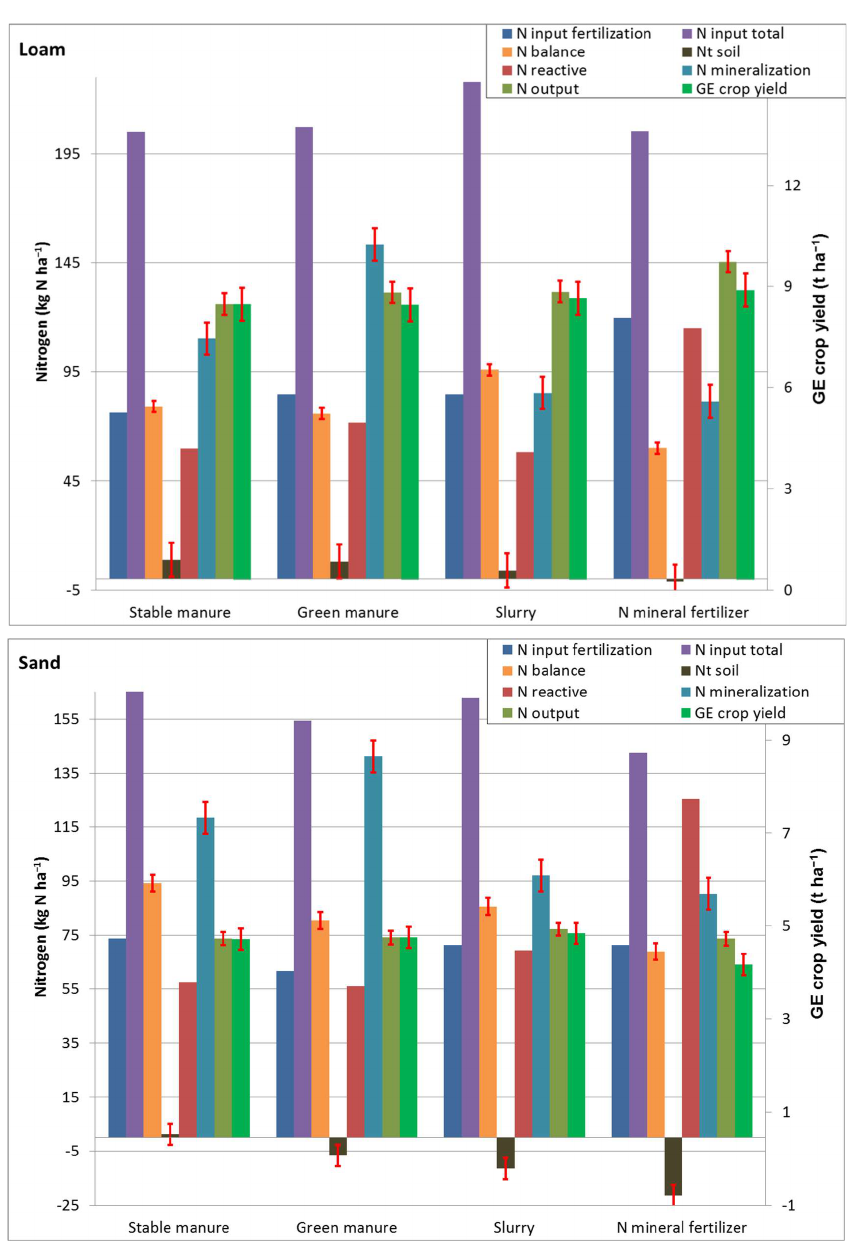
Figure 2. Comparison of some balance criteria, mineralization and reactive N, GE yield, and standard deviation (s) between long-term applied fertilizer types on loam soil ( top ) and sandy soil ( bottom ).